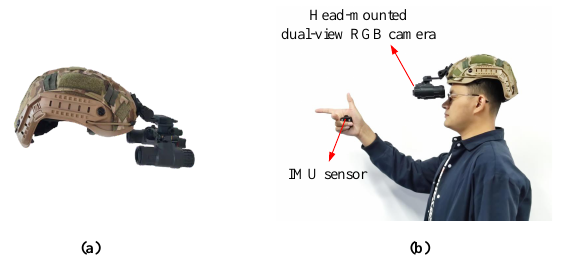
Figure 7. ( a ) Head-mounted dual-view RGB camera. ( b ) Schematic diagram of data acquisition.